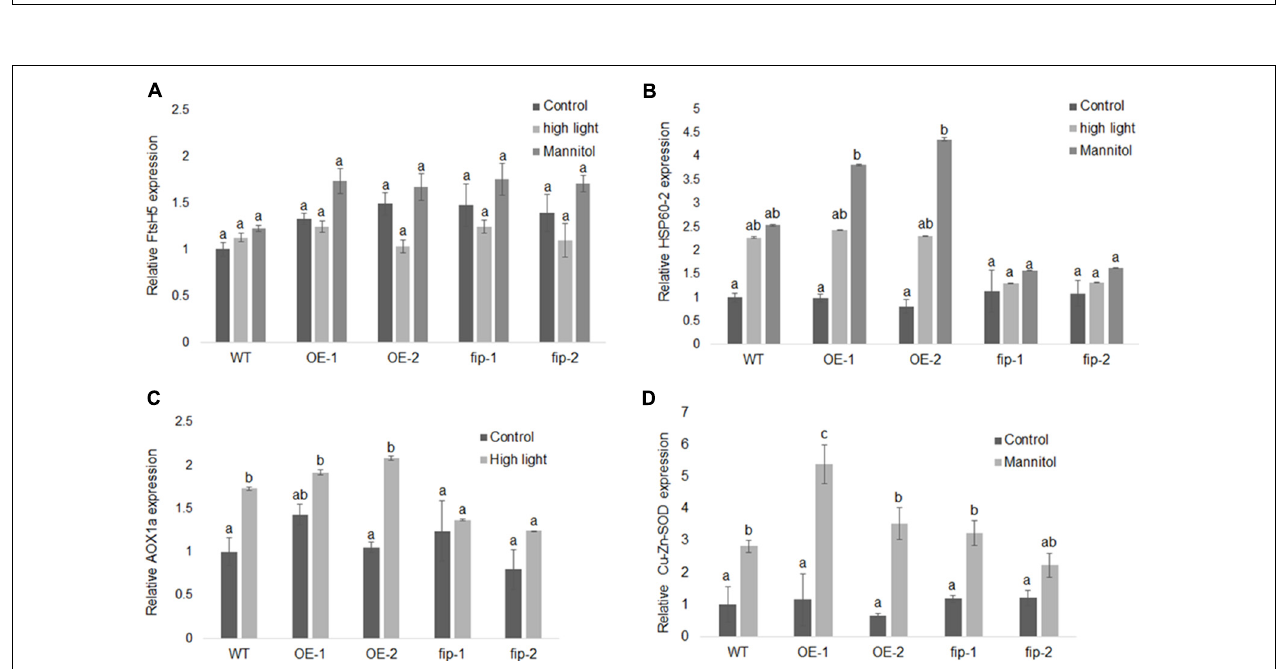
FIGURE 6 | Expression of different genes in response to stress conditions. Real-time RT-PCR analysis was conducted using WT plants, FIP overexpression lines (OE-1 and OE-2), and fip knockdown mutants ( fip-1 and fip-2 ). Three-week-old plants growing under control conditions (22 ◦ C, 16 h/8 h light/dark, 120 µ mol m − 2 s − 1 ) were submitted to a 24-h stress as follows: 400 µ mol m − 2 s − 1 (high light) or 300 mM of mannitol (osmotic stress). (A) Relative transcript levels of FtsH5 subjected to high light or osmotic stress. (B) Relative transcript levels of HSP60-2 in plants subjected to high light or osmotic stress. (C) Relative transcript levels of AOX1a in plants subjected to high light stress. (D) Relative transcript levels of Cu-Zn-SOD in plants subjected to osmotic stress. The relative expression was calculated by the (cid:49) CP method using ACTIN expression as the reference gene. Values were normalized in relation to the WT expression as 1. Data are the mean ± SD ( n = 6). Statistically significant differences are indicated by different lower-case letters (One-way ANOVA followed by Tukey, P < 0.05) when comparing all plants in the same graphic.